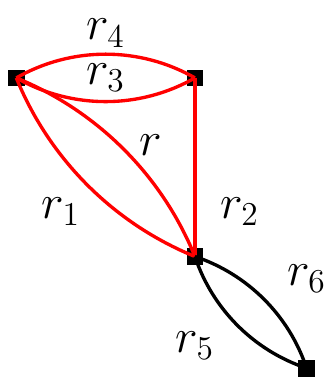
Figure 11 . Applying momentum conservation for a common edge to two cycles. In this case we get r = r + r + r = r + r . Here the resulting equation includes only r, r 1 3 4 1 2 in other cases we may get more momenta. This diagram scales as (cid:15) 4